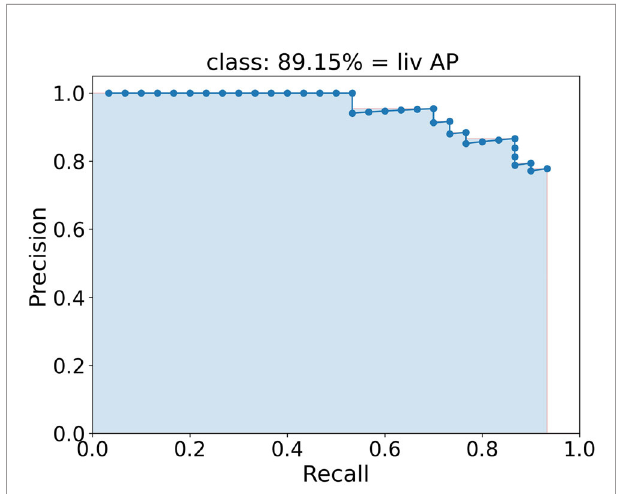
FIGURE 4 | Precision-recall curve (blue dotted line) to calculate the AP of class liv as example. The AP is calculated as the area of the interpolated precision-recall curve colored here in light blue and corresponds to 89.15